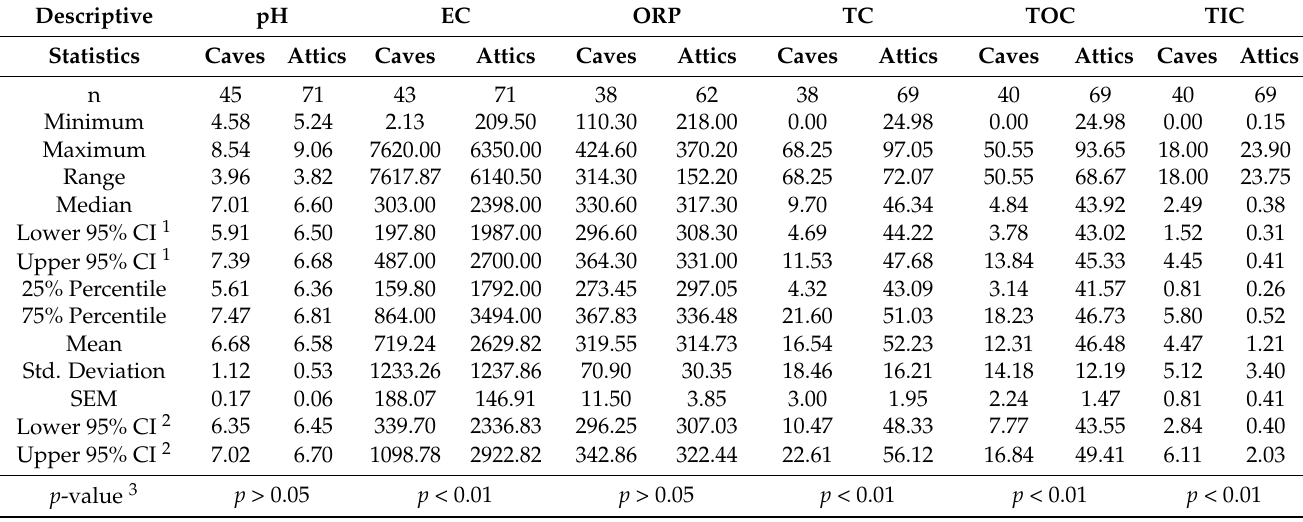
Table interpretation. EC = Electrical Conductivity ( μ S/cm); ORP = Oxidation-Reduction Potential (mV H ); TC = Total Carbon (%); TOC = Total Organic Carbon (%); TIC = Total Inorganic Carbon (%); n = Number of examined samples; CI = Confidence Interval; SEM = Standard Error of Mean; 1 Lower/Upper 95% CI of median; 2 Lower/Upper 95% CI of mean; 3 Mann– Whitney test p -value.